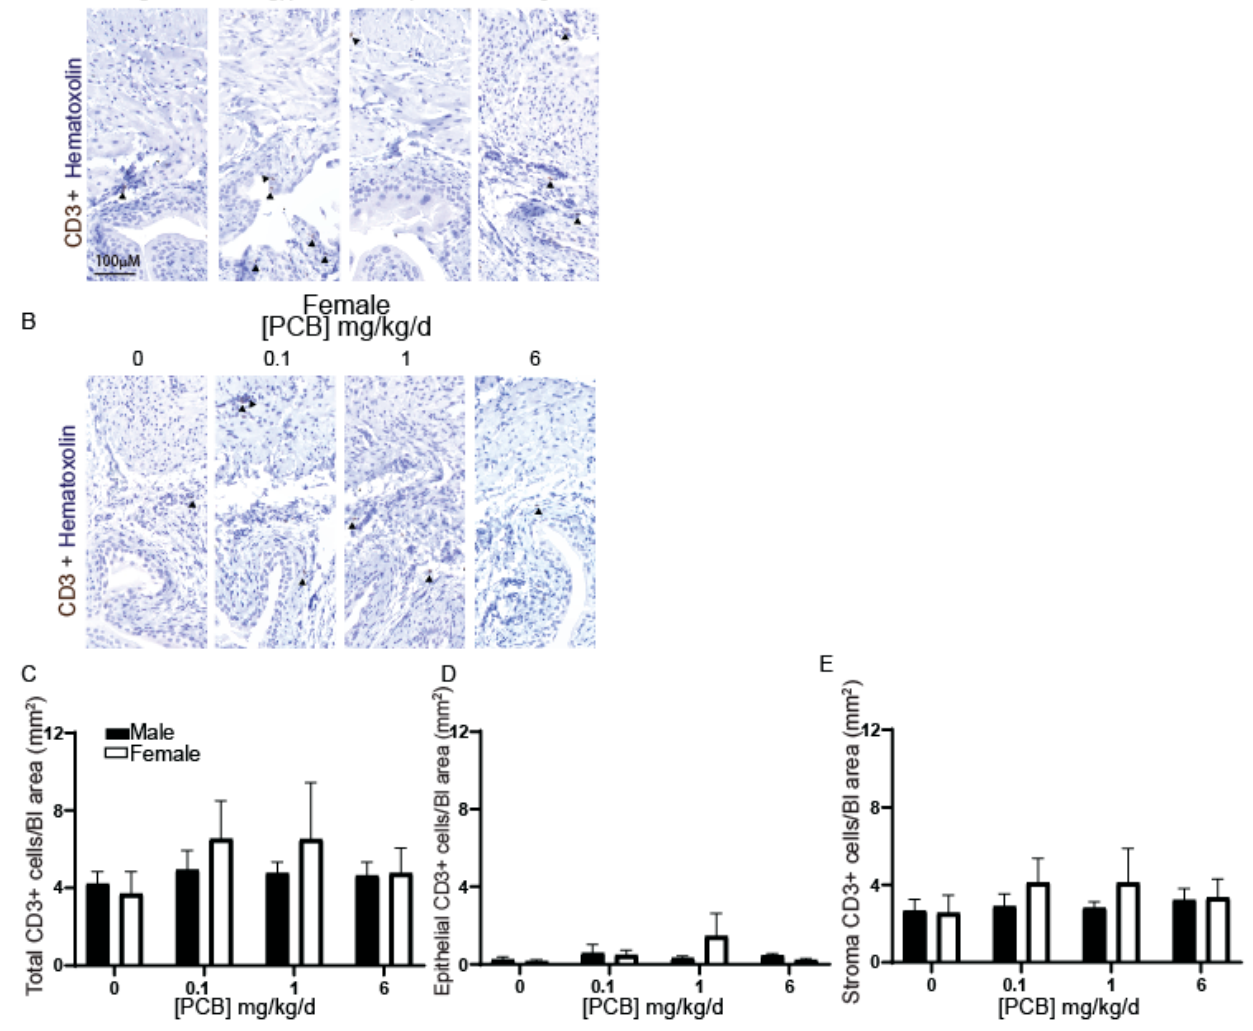
Figure 3. PCBs have no effect on CD3-positive immune cells in bladders of developmentally exposed mice. Mice were exposed to PCBs via maternal diet through gestation and lactation. Bladders were collected from young male and female offspring at postnatal day (P) 28–31 for immunohistochemistry. Representative images of ( A ) male and ( B ) female mouse bladders at each PCB treatment group incubated with antibodies targeting CD3 (brown) to label immune cells and hematoxylin (purple) to label all nuclei. Quantification of ( C ) the percent of total cells CD3 positive, ( D ) the percent of epithelial cells CD3 positive, and ( E ) the percent of stromal cells CD3 positive. Results are the mean ± SEM, n = 4–6 bladders per treatment group. No significant differences as determined by two-way ANOVA.